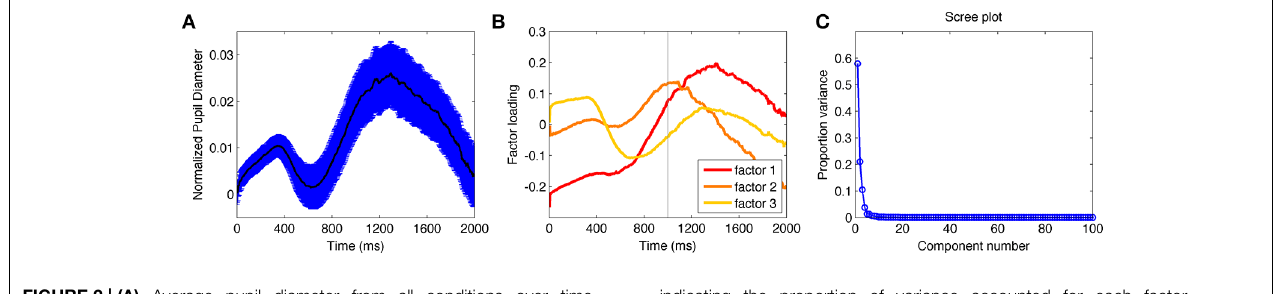
indicating the proportion of variance accounted for each factor (calculated from each eigenvalue divided by the sum of all